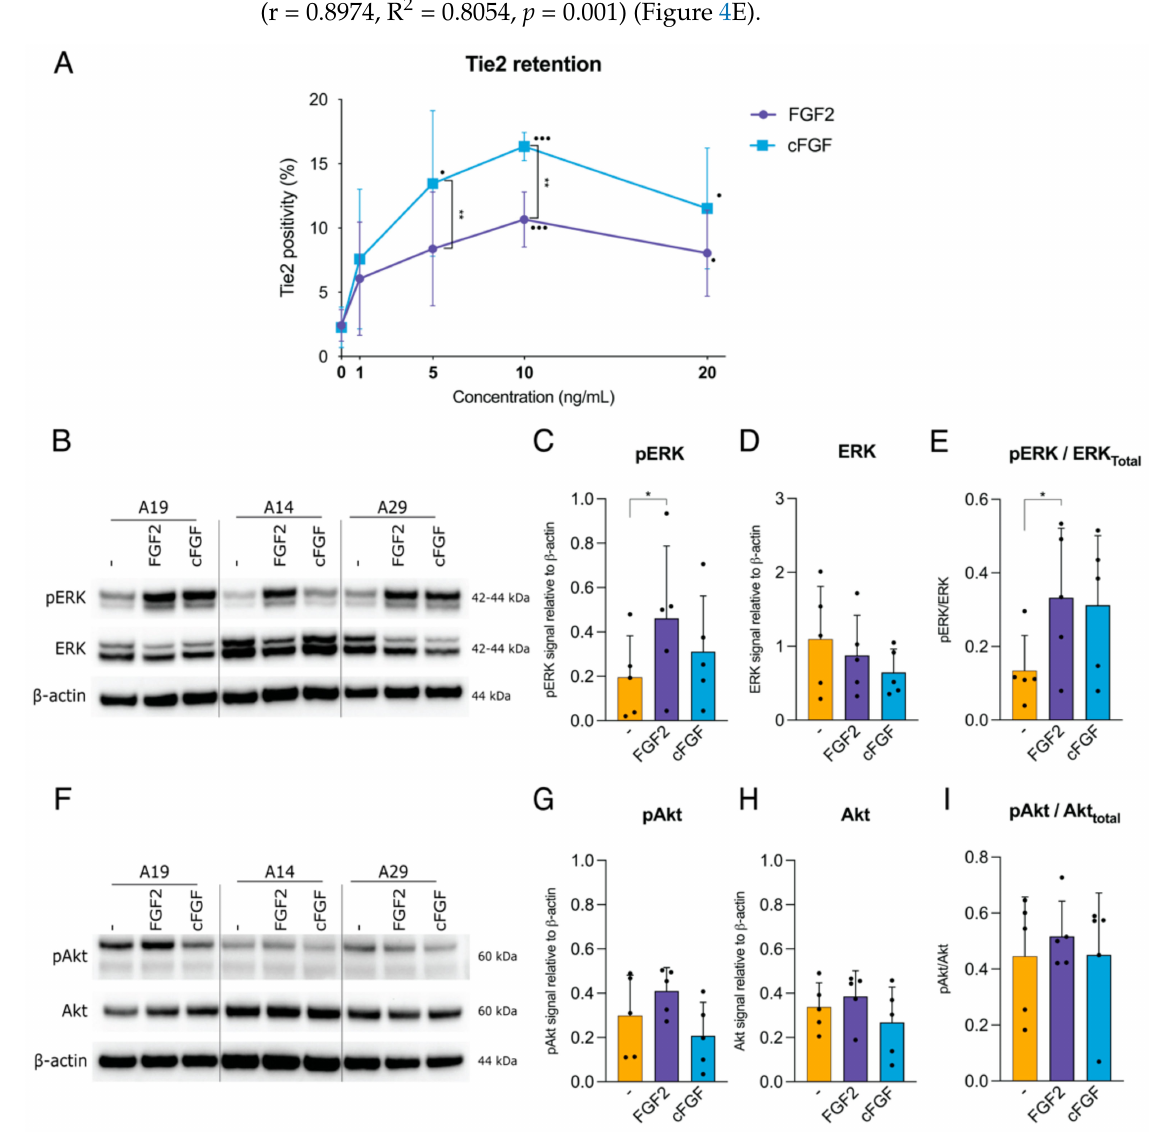
Figure 2. Examination of the involvement of the MEK/ERK and PI3K/Akt pathway in FGF2 and cFGF supported Tie2 retention. ( A ) Flowcytometry ( n = 5) determined fraction of Tie2 expressing NP cells following FGF2 and cFGF stimulation in non-serum condition for 24 h with a concentration of 1, 5, 10, or 20 ng/mL. ** p < 0.01 comparing FGF2 to cFGF, or • p < 0.05 ••• p < 0.001 compared to 0 ng/mL conditions. ( B ) Representative western blot of three donors (A19, A14, A29, Table 1) for ERK activation, following stimulation with 10 ng/mL FGF2 or cFGF. β -actin was applied as a loading control. Quantification of ERK activation western blot ( n = 5), presenting ( C ) pERK and ( D ) ERK values relative to β -actin signal. ( E ) Quantification of pERK values relative to total ERK. ( F ) Western blot for three representative donors (A19, A14, A29, Table 1) for Akt activation, following stimulation with 10 ng/mL FGF2 or cFGF. β -actin was applied as a loading control. Quantification of Akt activation western blot ( n = 5), presenting ( G ) pAkt and ( H ) Akt values relative to β -actin signal. ( I ) Quantification of pAkt values relative to total Akt signal. All values presented as means, and error bars represent standard deviation. * p < 0.05—indicates unstimulated cells and • shows each sample